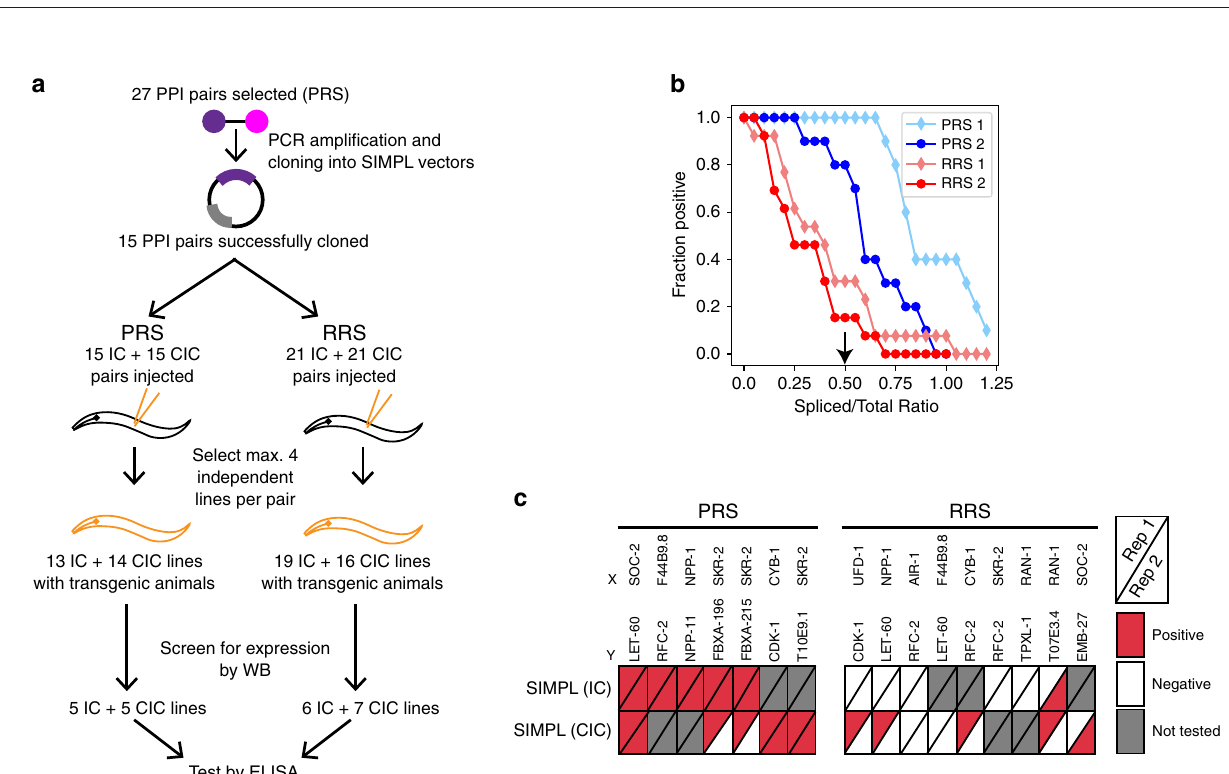
Fig. 4 Detection of physiological PPIs and their inhibition with SIMPL. a EGFR/SHC1 interaction. EGFR WT, inactive (D855A), or constitutively active (L858R) mutants in IN format were co-expressed with SHC1 (IC) in HEK 293 cells. Their interactions were analyzed with western analysis. b KRAS/RAF interaction. RAF1-IN and IC-KRAS (WT, inactive S17N mutant, or active G12D or Q61H mutant) were transiently expressed in HEK 293 cells followed by western analysis. c Stable cells derived from HEK 293 T-Rex FlpIn with EGFR (IN) and SHC1 (IC) inserted into the FRT site were treated with the indicated different concentrations of tetracycline for 6 h, followed by treatment with EGF (100 ng/ml) for 2 min and then analysis by western blot. s.e. short exposure, l.e. long exposure. Each blot in a – c is representative of three independent experiments. d SIMPL analysis of kinase/substrate interactions. The indicated kinase-IN constructs were individually expressed along with their substrates in either IC or CIC format and their interactions were detected by ELISA assay. LSM2 was used as a negative control prey. e Mitochondrial PPIs. The selected mitochondrial bait proteins were constructed in IN format. They were then co-expressed with the indicated preys in either IC or CIC format, or in both. The interactions were examined with ELISA. LSM2 was used as a negative control prey. OMM outer mitochondrial membrane, IMS intermembrane space, IMM inner mitochondrial membrane. f Retest of PDHA1/PDHB interaction with ELISA-coupled SIMPL. In one sample (the fourth from left), the mitochondrial targeting sequence of PDHA1 was replaced by a nuclear localization sequence. In the last sample (the fi rst from right), WT PDHA1 and PDHB were expressed in separate cells and the cell lysates were mixed for ELISA. The experiments in d – f were performed in triplicates and their mean values are presented as bars with each replicate shown in a single dot. Source data are available in the Source Data fi le.